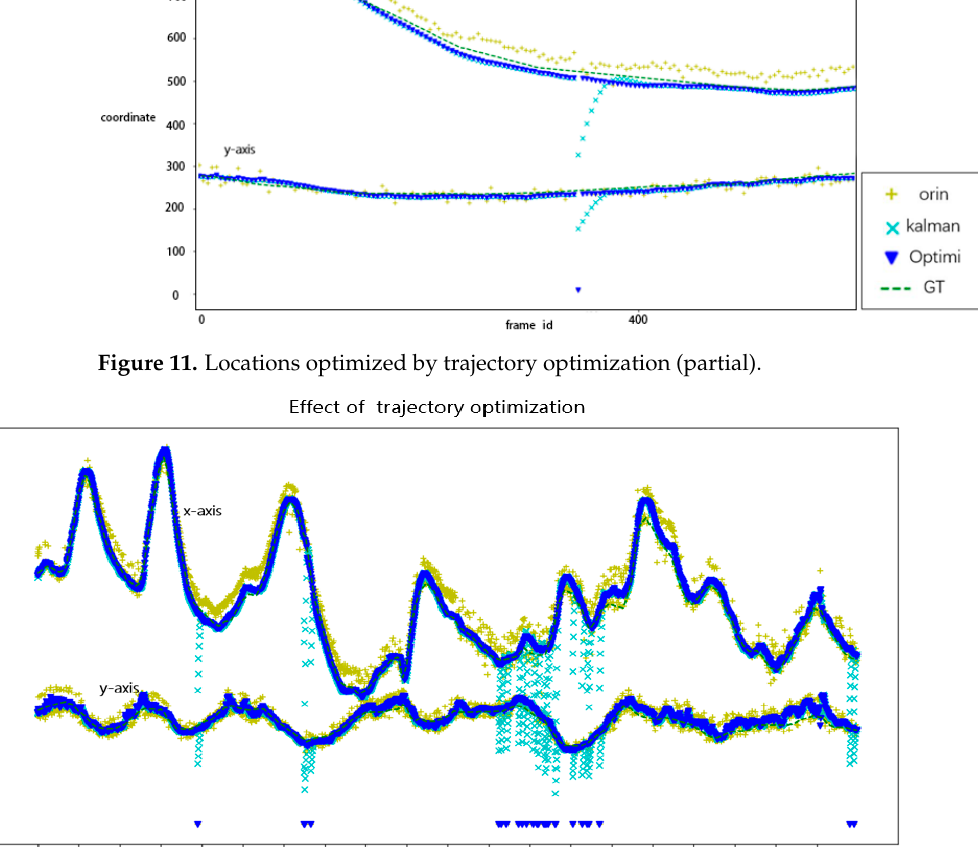
Figure 12. Locations optimized by trajectory optimization.